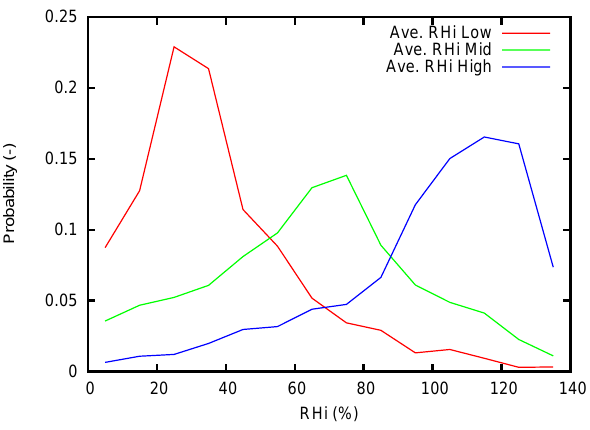
Fig. 13. Probability densitiy functions of RHi distributions in thick pressure levels and three average relative humidity bins. A low bin (average RHi 15–20%, orange line), mid-bin (55–60%, green line), and a high bin (115–120%, turquoise line). The distributions are derived from the British Isles dataset (January 2002–December 2006).